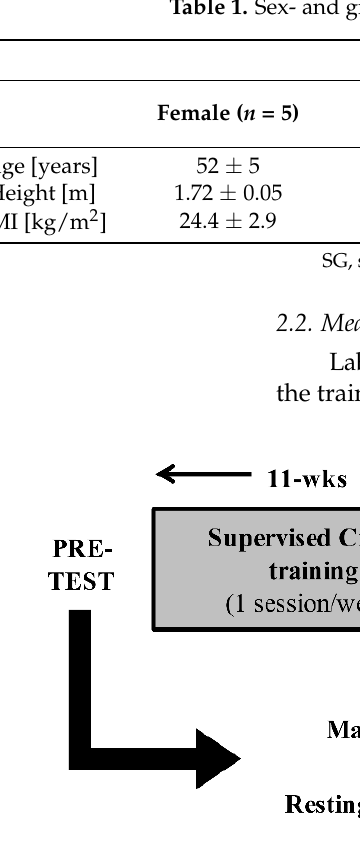
Figure 1. Timeline and main measurements of the study. BLApeak, peak blood lactate concentration; BP, blood pressure; VO 2 peak, peak oxygen uptake; PPO, peak power output; NIRS, near infrared spectroscopy; wks, weeks.